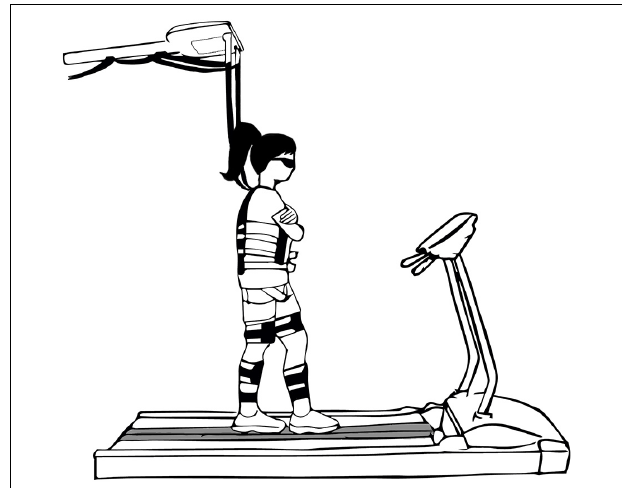
FIGURE 1 | A sketch of a participant walking on the treadmill-mounted balance beam while wearing the occlusion glasses and safety harness. The participants wore a harness for safety that allowed for freedom of movement in the mediolateral